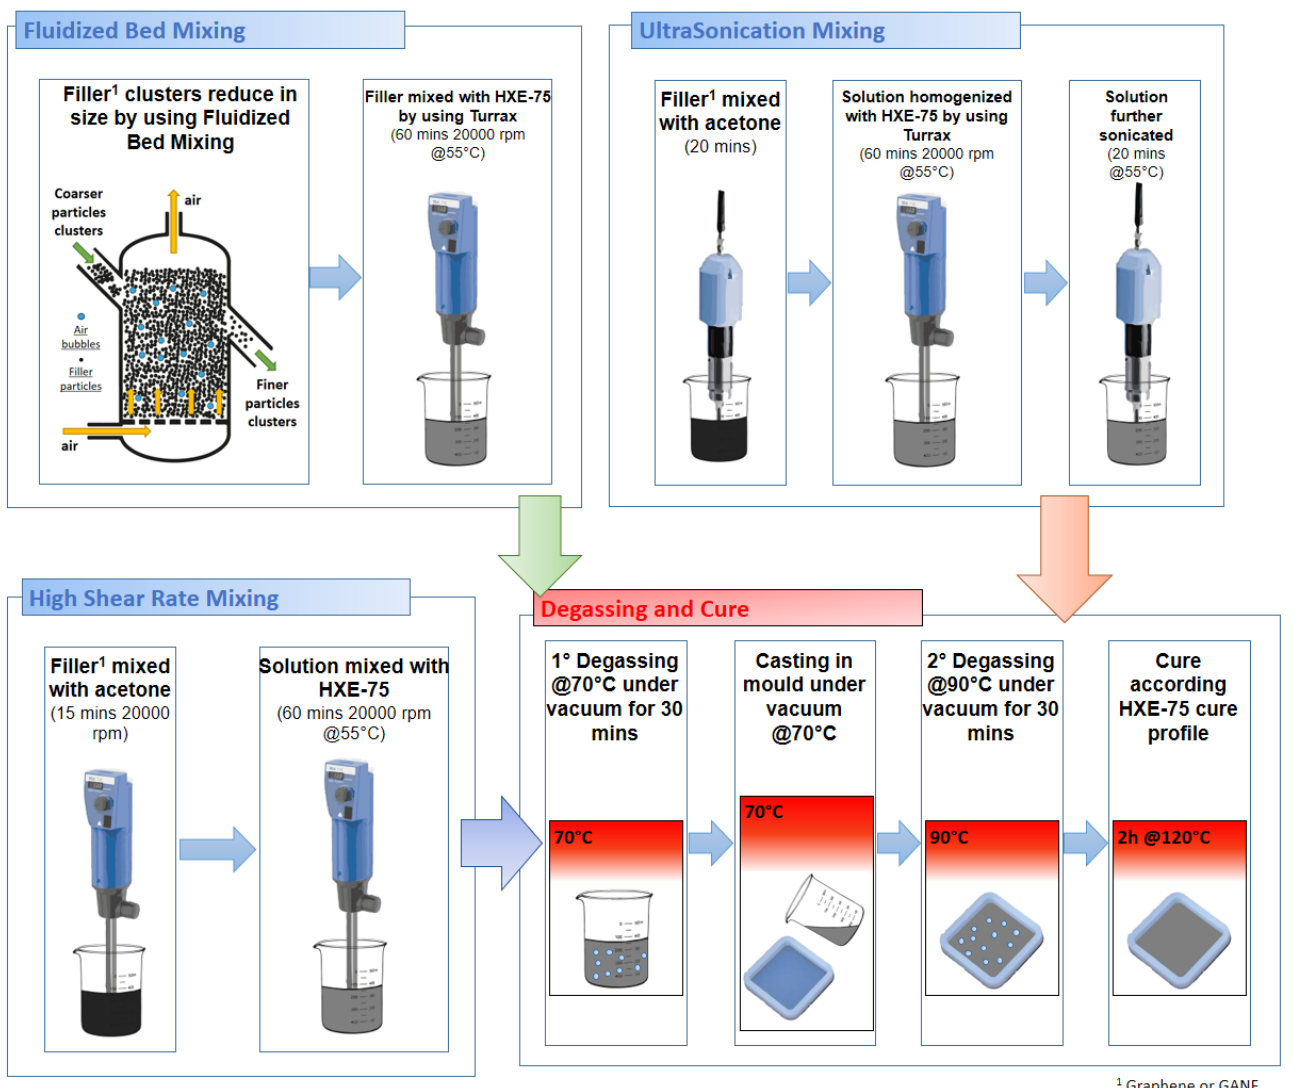
Table 1. List of the manufactured